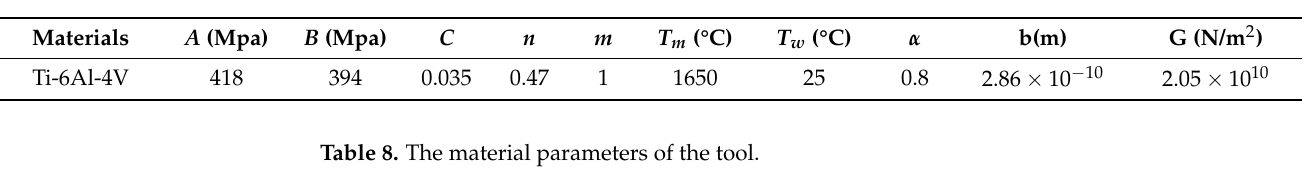
Table 7. The Johnson–Cook parameters of Ti-6Al-4V [39].